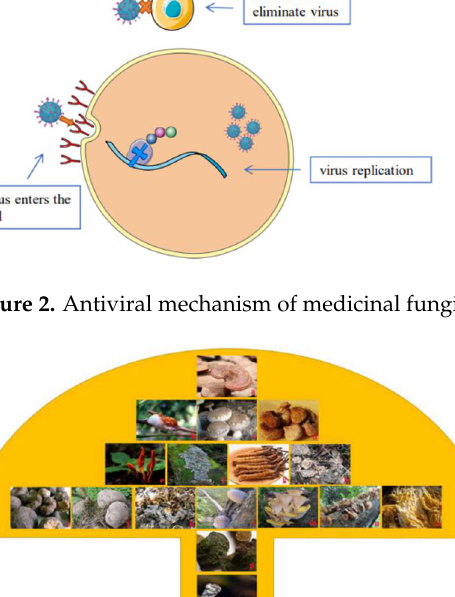
Figure 1. Medicinal fungi antiviral actions.